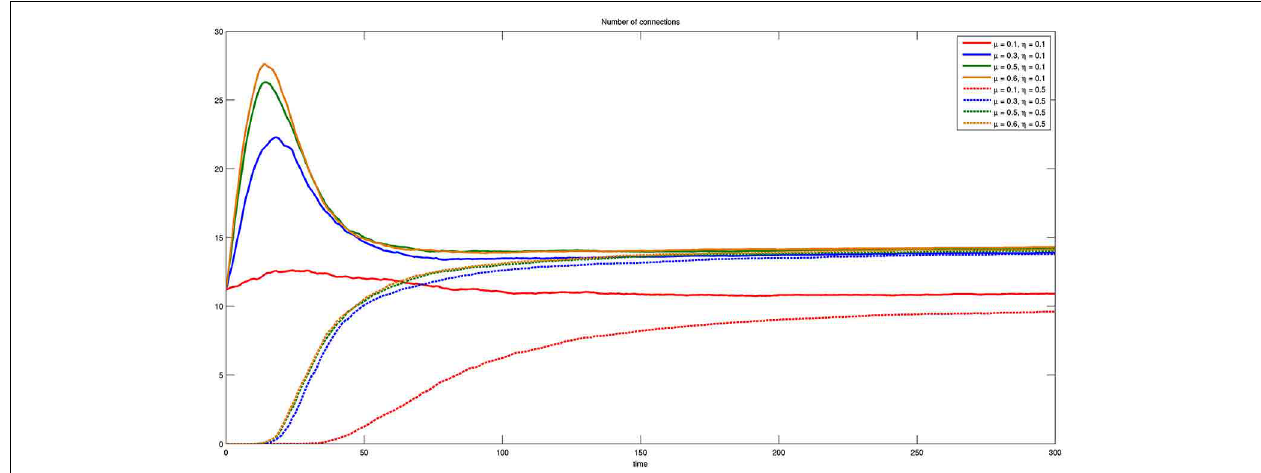
FIGURE 12 | Time course of the number of connections for different values of η and μ . Here η = { 0 . 1 , 0 . 5 } and μ = { 0 . 1 , 0 . 3 , 0 . 5 , 0 . 6 } . The presence of initial connections and transient behavior are evident for η = 0 .